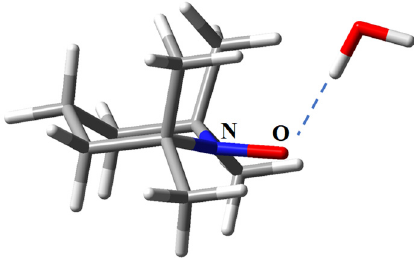
Figure 12. Hypothetical TEMPO ... H 2 O complex used to test the response of computed hyperfine coupling to environment effects (by comparison with pristine TEMPO result).